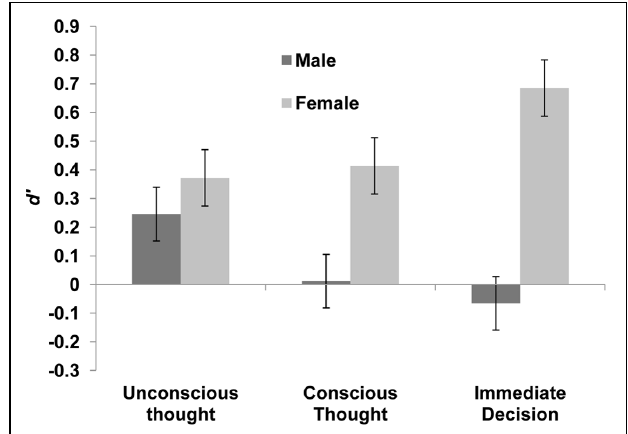
FIGURE 2 | Mean d (cid:2) of males and females in each condition of Experiment 2 with + 1/ − 1 SE